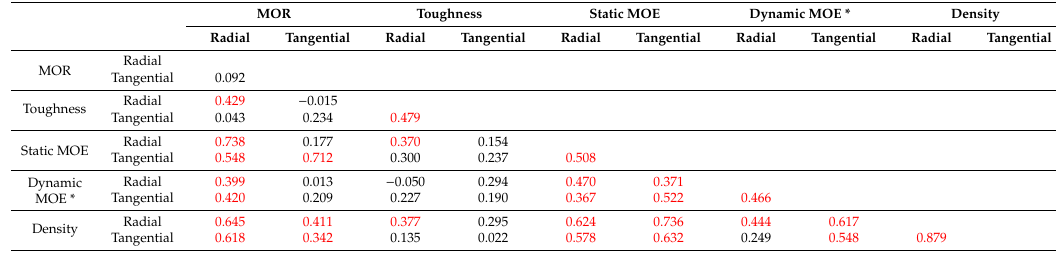
Table A4. Values of Correlation Coe ffi cients Between Given Quantities for Spruce Wood.